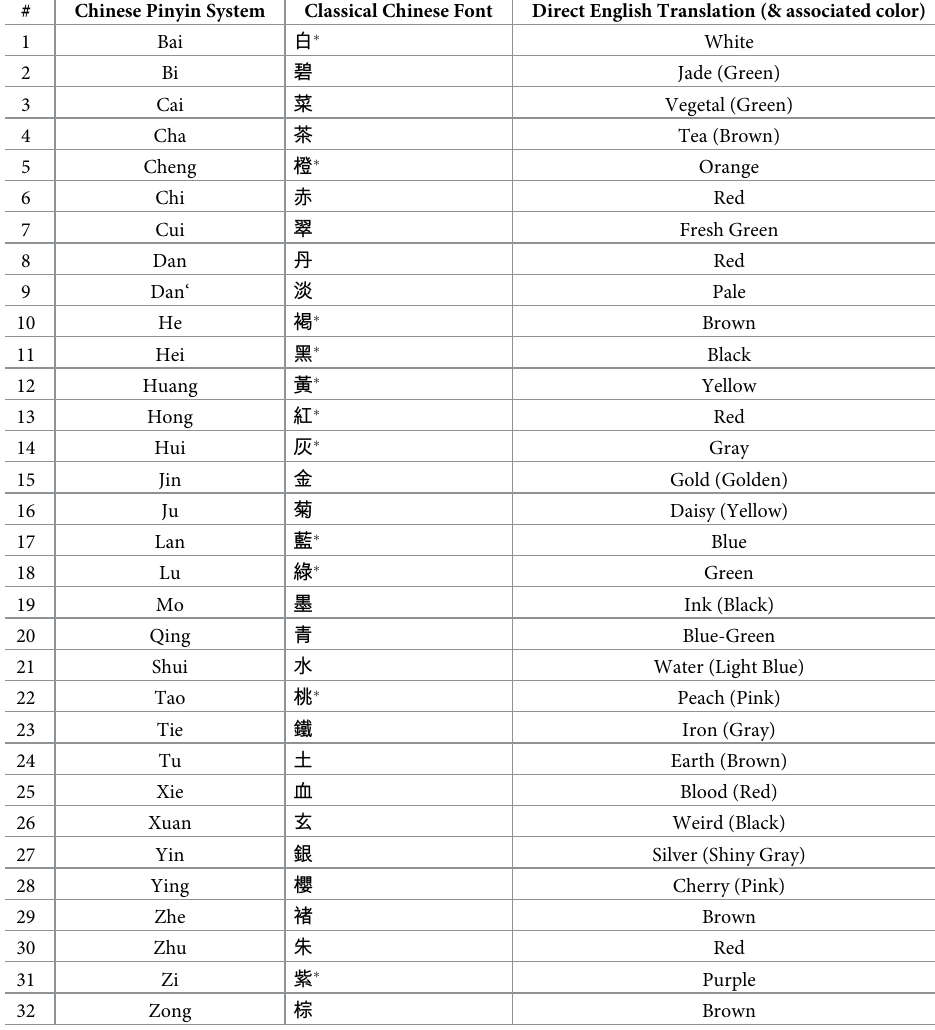
� The Mandarin basic color terms suggested by Lu¨